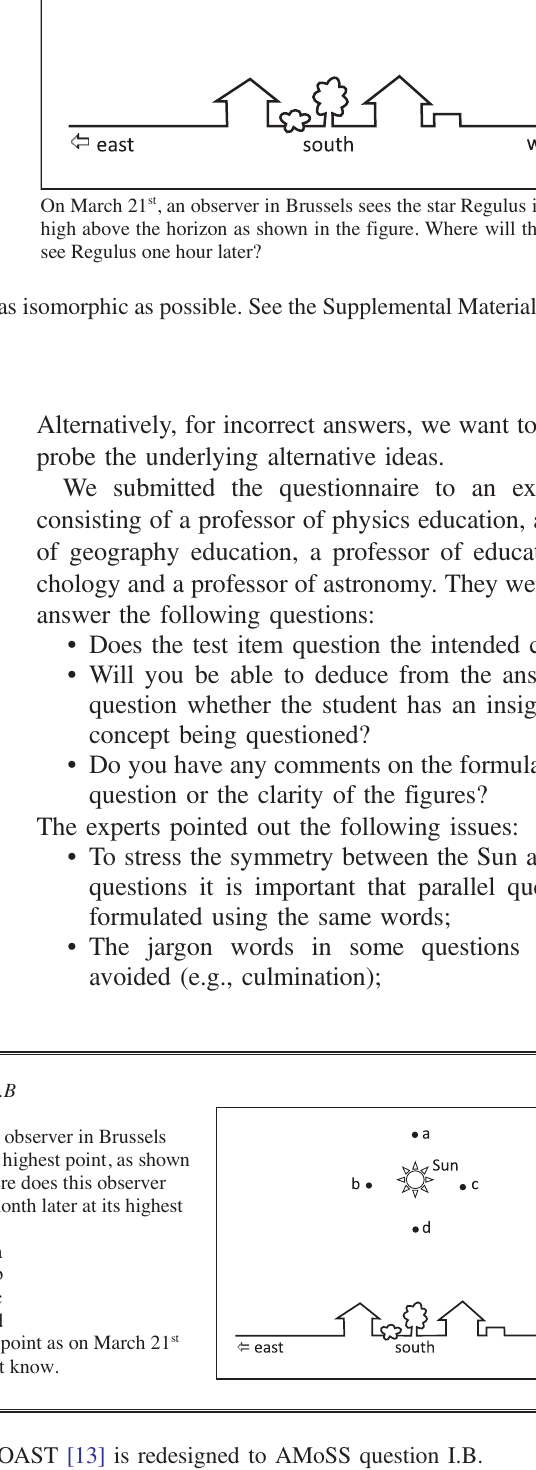
FIG. 2. Example of how test item 4 of the TOAST [13] is redesigned to AMoSS question